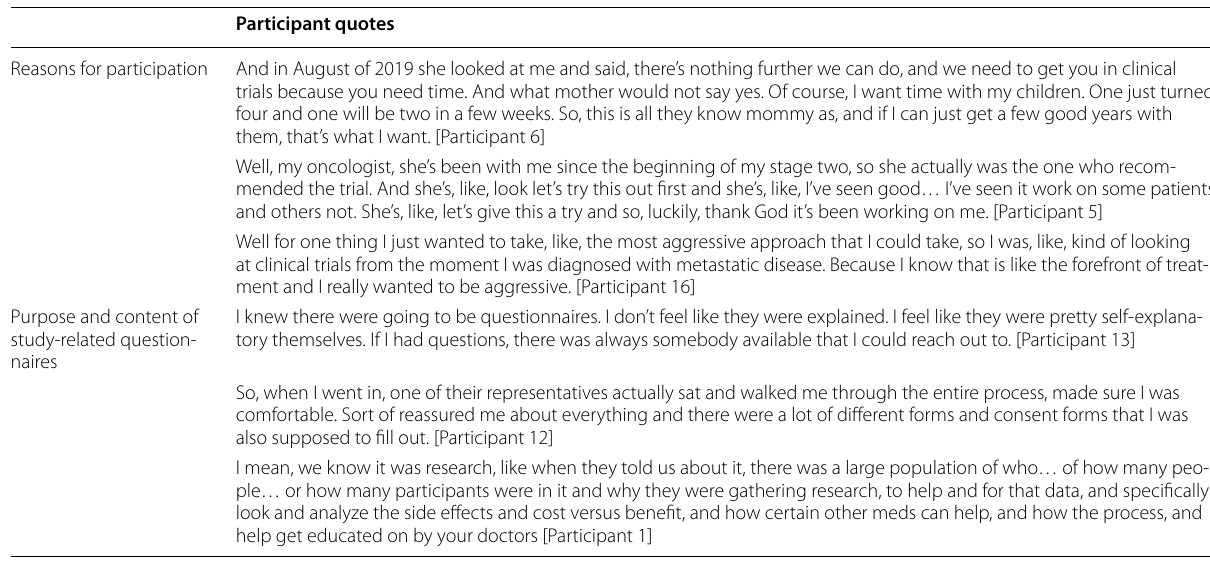
Table 4 Reasons for patients’ participation in clinical trials and understanding of the purpose/content of PRO